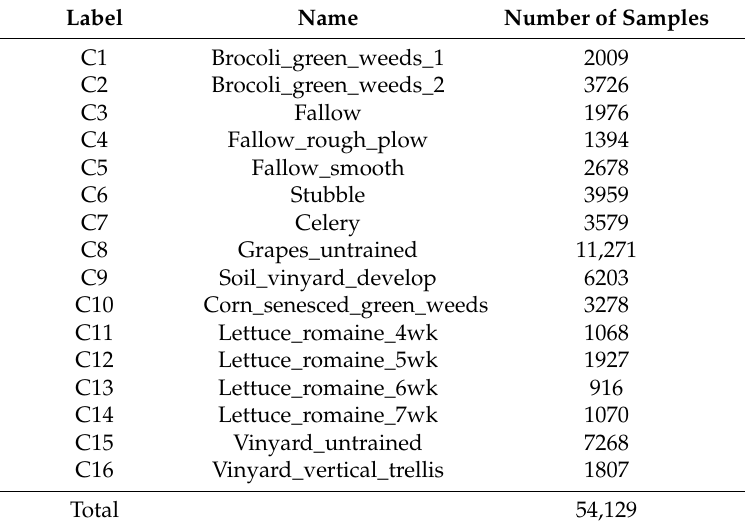
Table 2. Salinas dataset ground object type